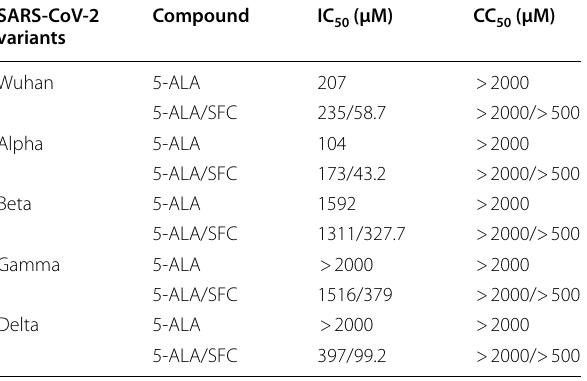
Table 1 IC and CC values of 5-ALA and 5-ALA with SFC 50 50 against SARS-CoV-2